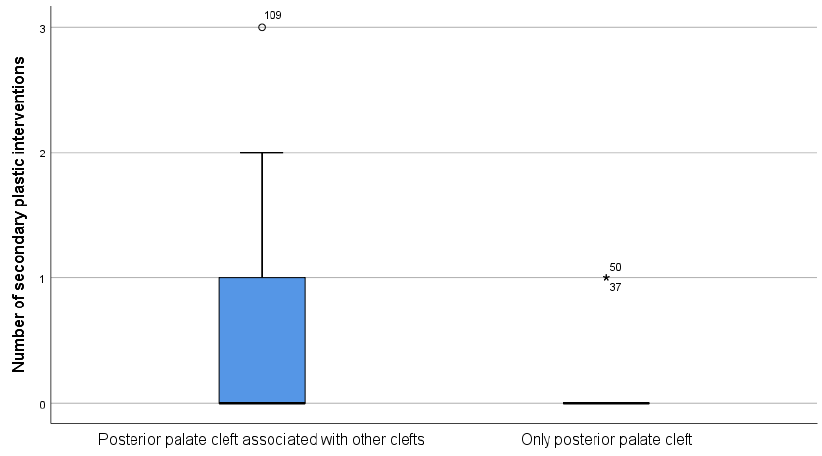
Figure 6. Box and whisker plots comparing the number of secondary palatal surgical interventions based on the type of cleft. “*”—outliers.